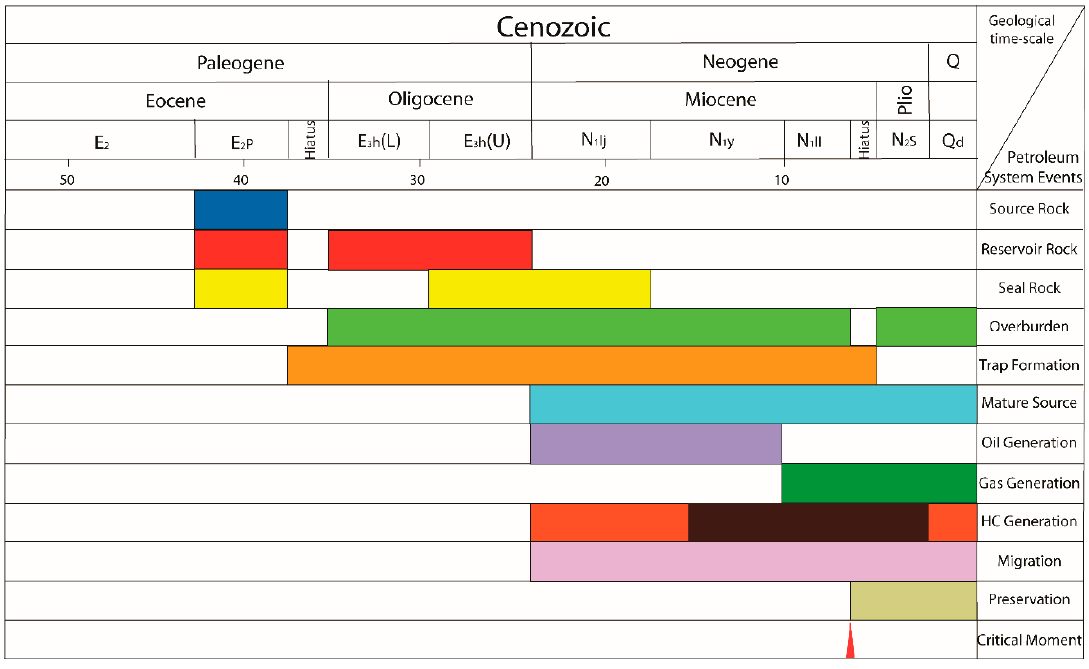
Figure 8. Event chart of the Pinghu–Huagang Petroleum System (!) in the Xihu Sub-basin.